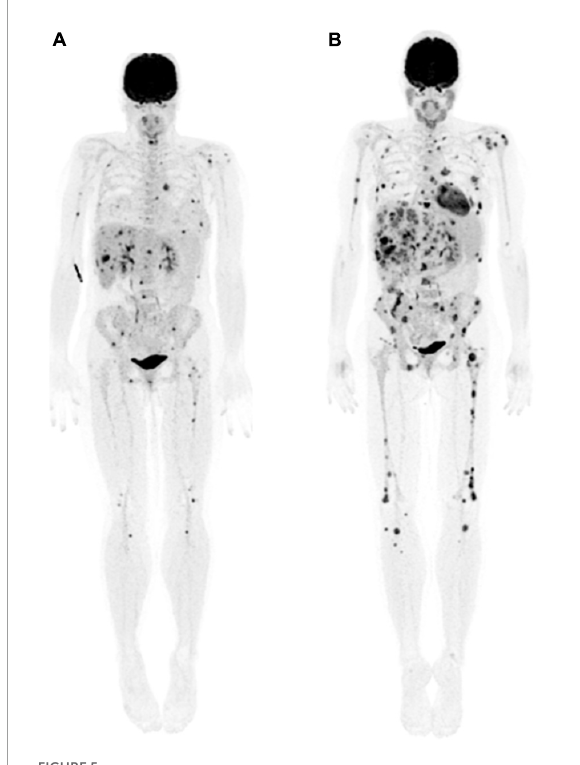
FIGURE5 44-year-old woman with presumed stage IIIB melanoma of right buttock. (A) Maximum intensity projection whole body 18 F-FDG PET image showed extensive metabolically active metastatic disease in the breasts, liver, and skeleton. (B) Three months following initiation of immunotherapy, follow-up maximum intensity projection whole body 18 F-FDG PET image showed interval development of innumerable new liver, skeletal and breast lesions, most with diameter < 15 mm, in keeping with progressive disease according to PERCIMT